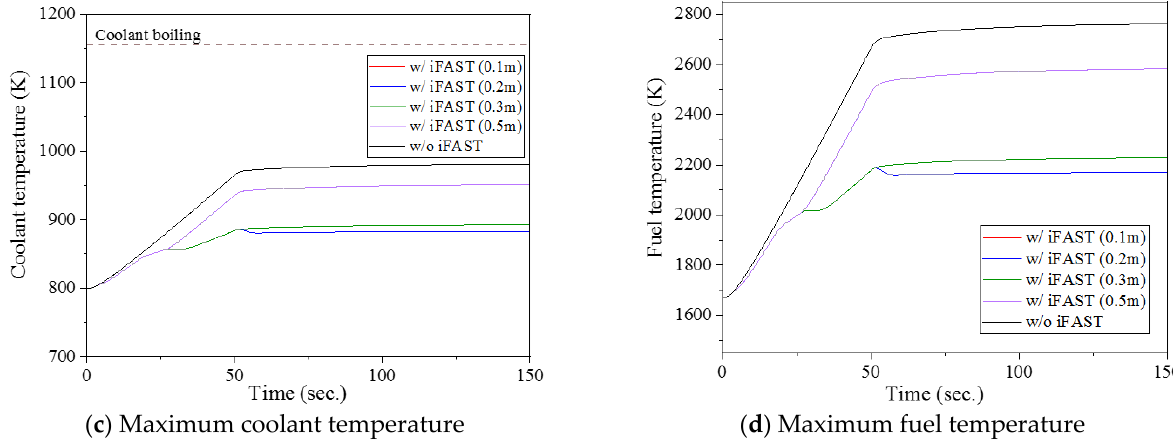
Figure 11. Unprotected transient over power (1$/50 s) with constant inlet temperature and 1$ maximum iFAST worth.